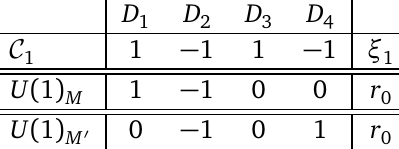
Figure 34: Sample slices of the moduli space of the beetle geometry, (contd). Turning on different mass deformations reveals more SU ( 3 ) N (o) and (r) as in (i) and (ii), but also non-gauge theoretic phases such as (u) in (vii) and (t) in